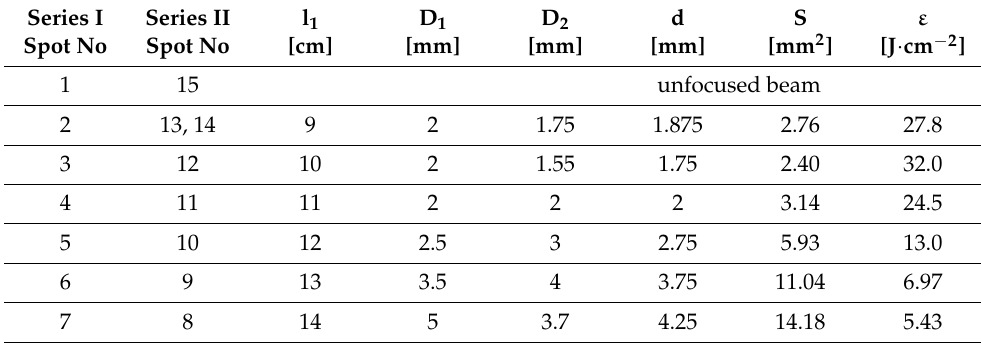
Table 1. Averaged diameter d of the spots in Figure 1 and the incident fluences ε (the diameters and fluences of the spots in series II are the same as for the spots in series I).